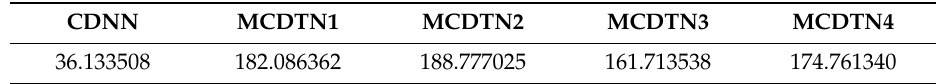
Table 12. The runtime of structurally-complete fault diagnosis model without and with transfer learning in o ffl ine.(unit: second).